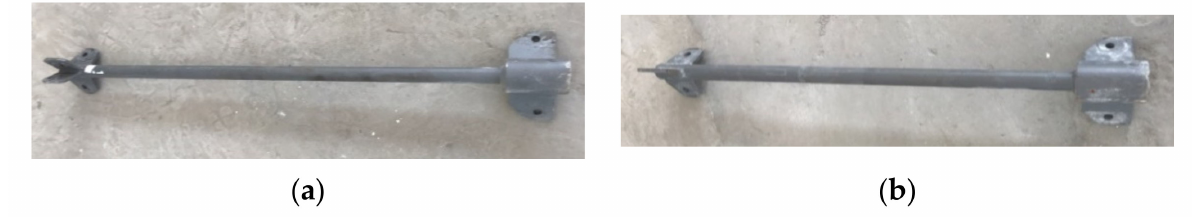
Figure 8. Photographs of the struts. ( a ) ST-1; ( b ) ST-2.